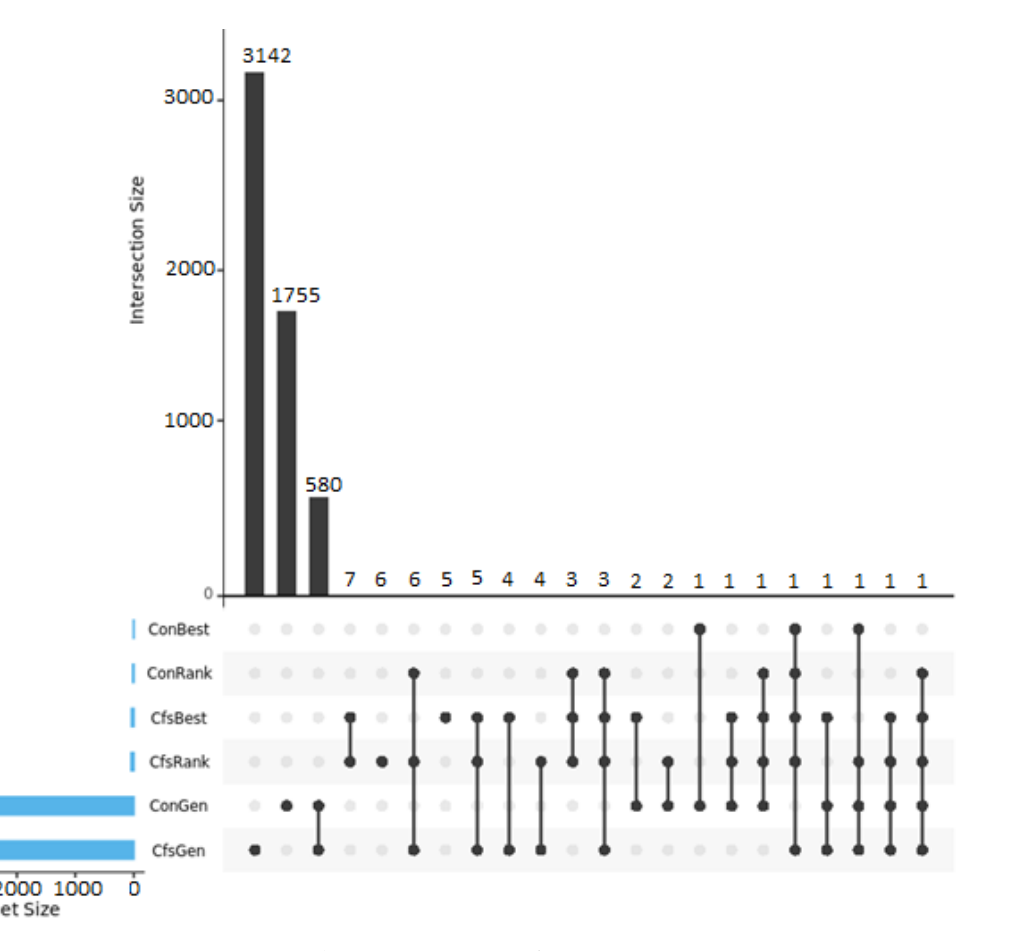
Figure 4. Intersection